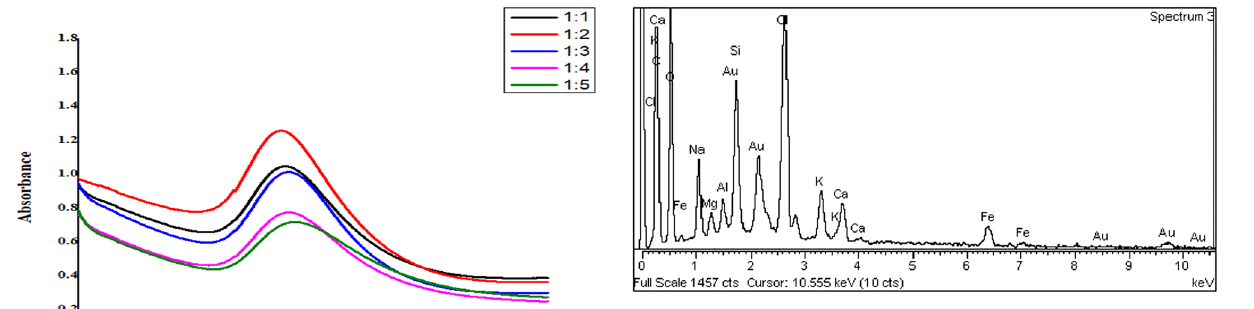
Figure 4: SEM and EDX spectra of SE - mediated AuNPs showing the optical density of metallic